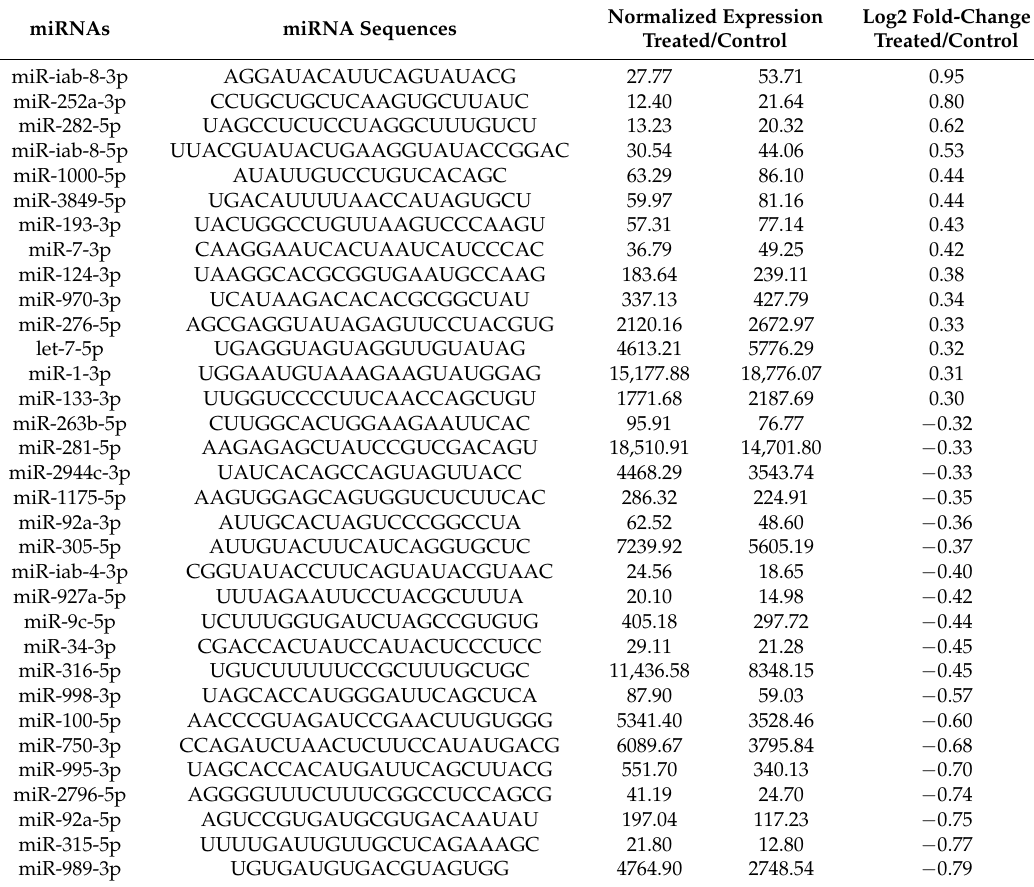
Table 3. Differential expression of 33 miRNAs following imidacloprid treatment in L. decemlineata . miRNAs miRNA Sequences